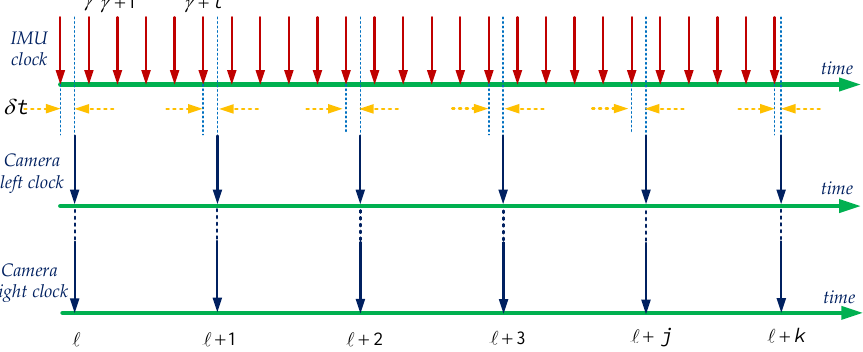
Figure 4. The demonstration of stereo camera and IMU clock. The left and the right camera are synchronized by software while having a time offset between the camera clock and the closest IMU